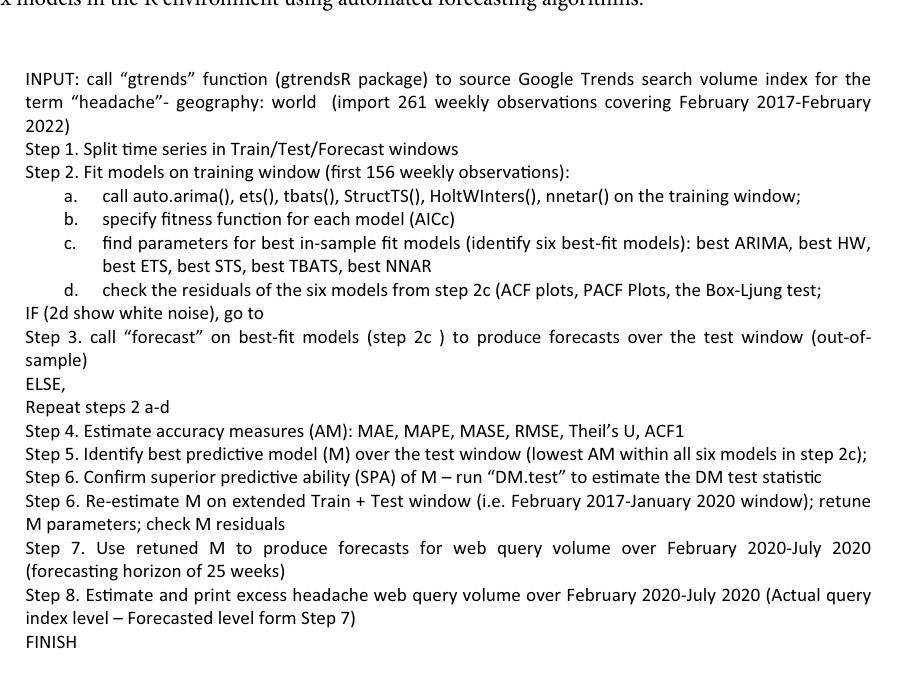
Table 1 reflects the accuracy measures for the out-of-sample forecasting ability of the six models over the test- ing period. Results indicate that Holt-Winters and NNAR can provide the best forecast for web-queries, thus over-performing within the universe of six competing models when predicting the level of the web search index over the testing period. Theil’s U statistic is also sub-unitary for the two models, implying that all issued predictions are superior to the naïve method. The other predictive models show significantly higher accuracy measures, indicating that none has been able to satisfactorily capture the evolution of web-queries. Furthermore, the DM test confirms (p value = 0.046) that HW is over-performing within the pool of concurrent models and